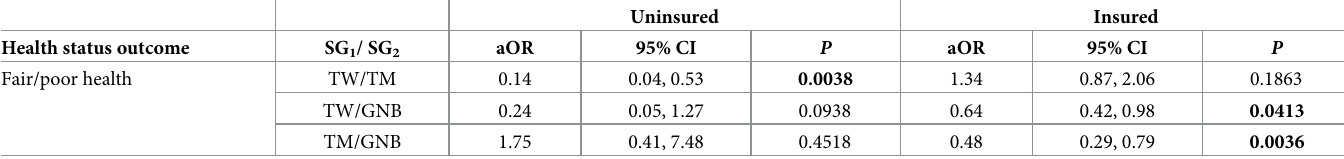
Table 7. Final multivariable model results: A posteriori contrasts for study group interaction for the fair/poor health outcome.